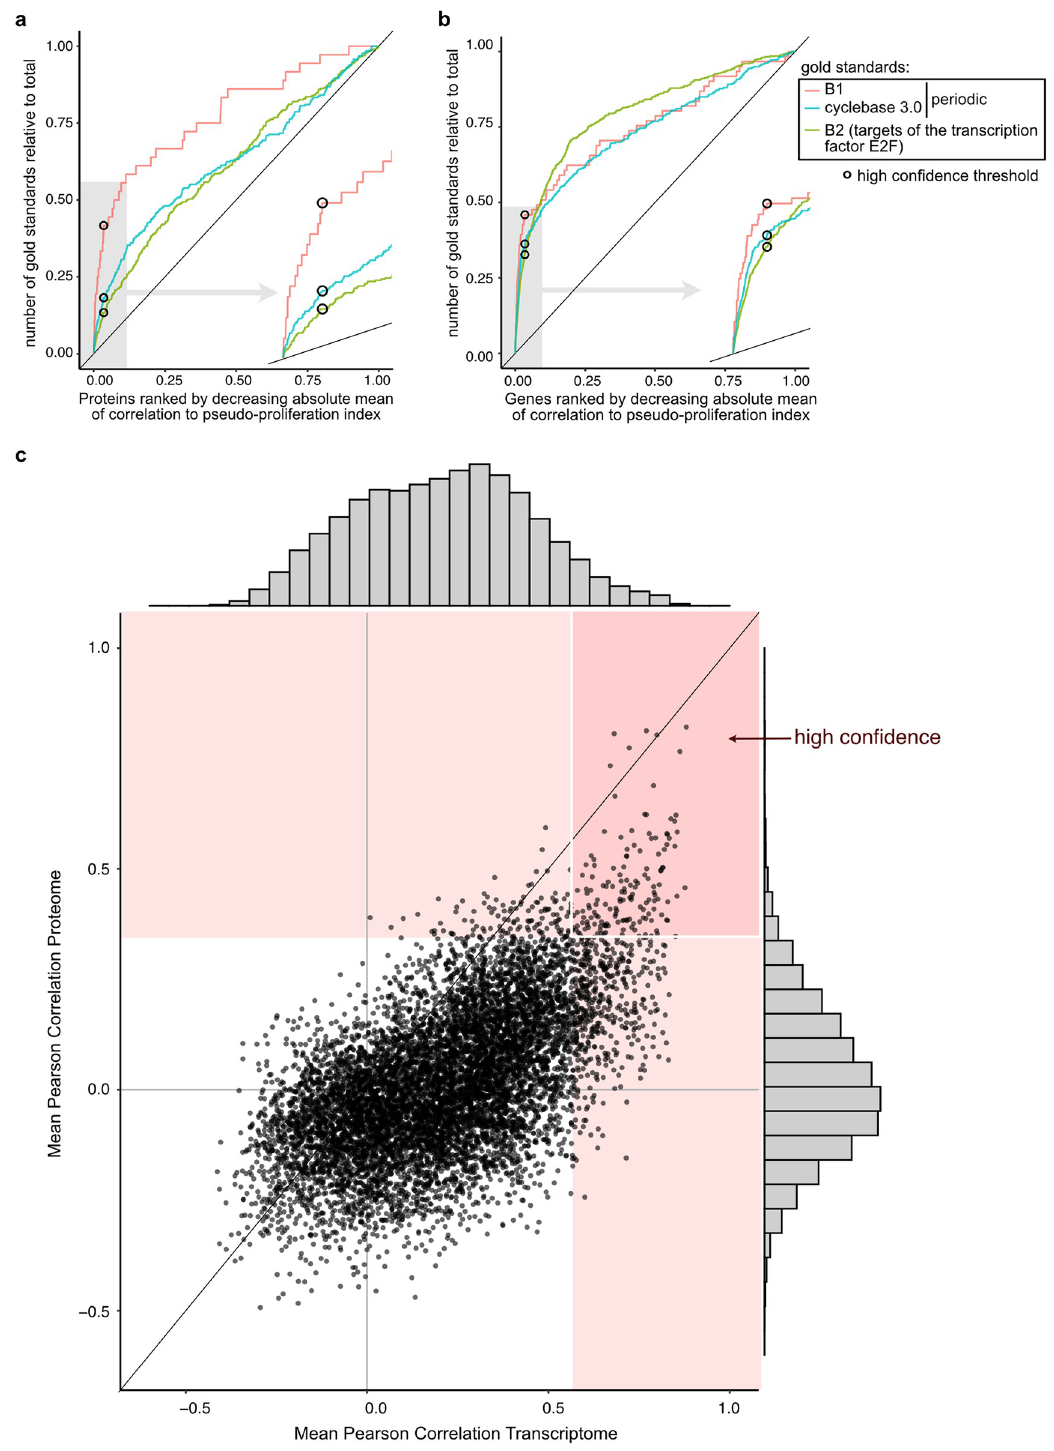
Fig 2. Signature genes of cell proliferation. a-b) Definition of the cutoff for correlation with pseudo-proliferation index with three sets of gold standards in the proteomes (a) and the transcriptomes (b). Proteins/genes were ranked by decreasing absolute Pearson correlation to pseudo-proliferation index (horizontal axis) and the vertical axis presents the cumulative number of gold standards for each set. Proteins/genes quantified in less than 3 and 2 data sets were excluded in (a) and (b), respectively. c) Scatter plot of the mean Pearson correlation to pseudo-proliferation index at protein (vertical axis) and transcript (horizontal axis)